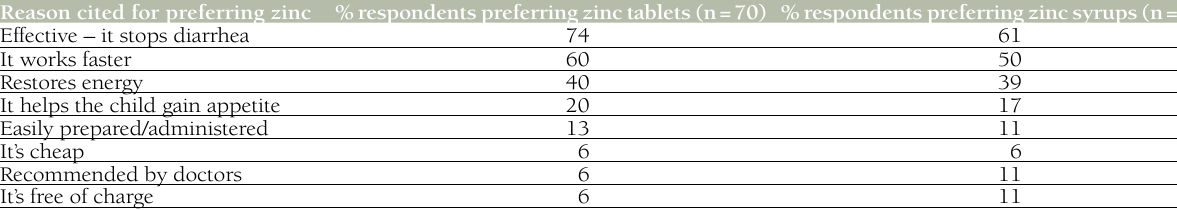
Table 6. Reasons for preferring zinc over other products